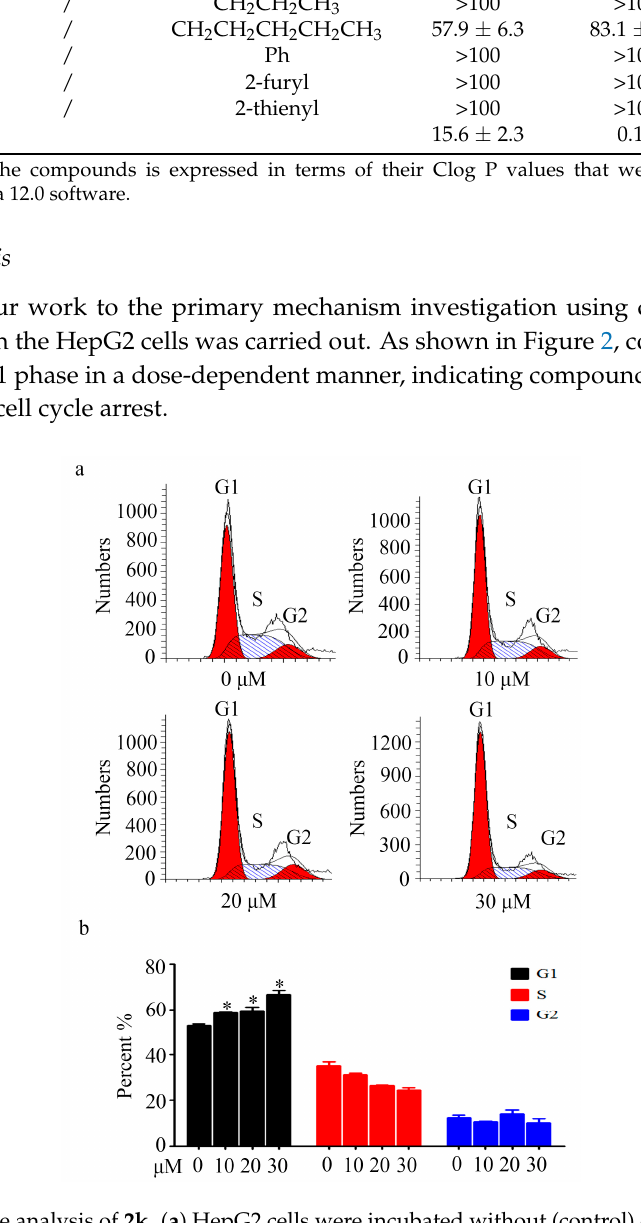
Figure 2. Cell cycle analysis of 2k . ( a ) HepG2 cells were incubated without (control) or with compound at different concentrations (10, 20, 30 µ mol/L) for 24 h-and then analyzed for their cell cycle distribution using flow cytometry; ( b ) The percentage of each population was shown as mean ± SD. Data is the representative of three independent experiments. * p < 0.05.